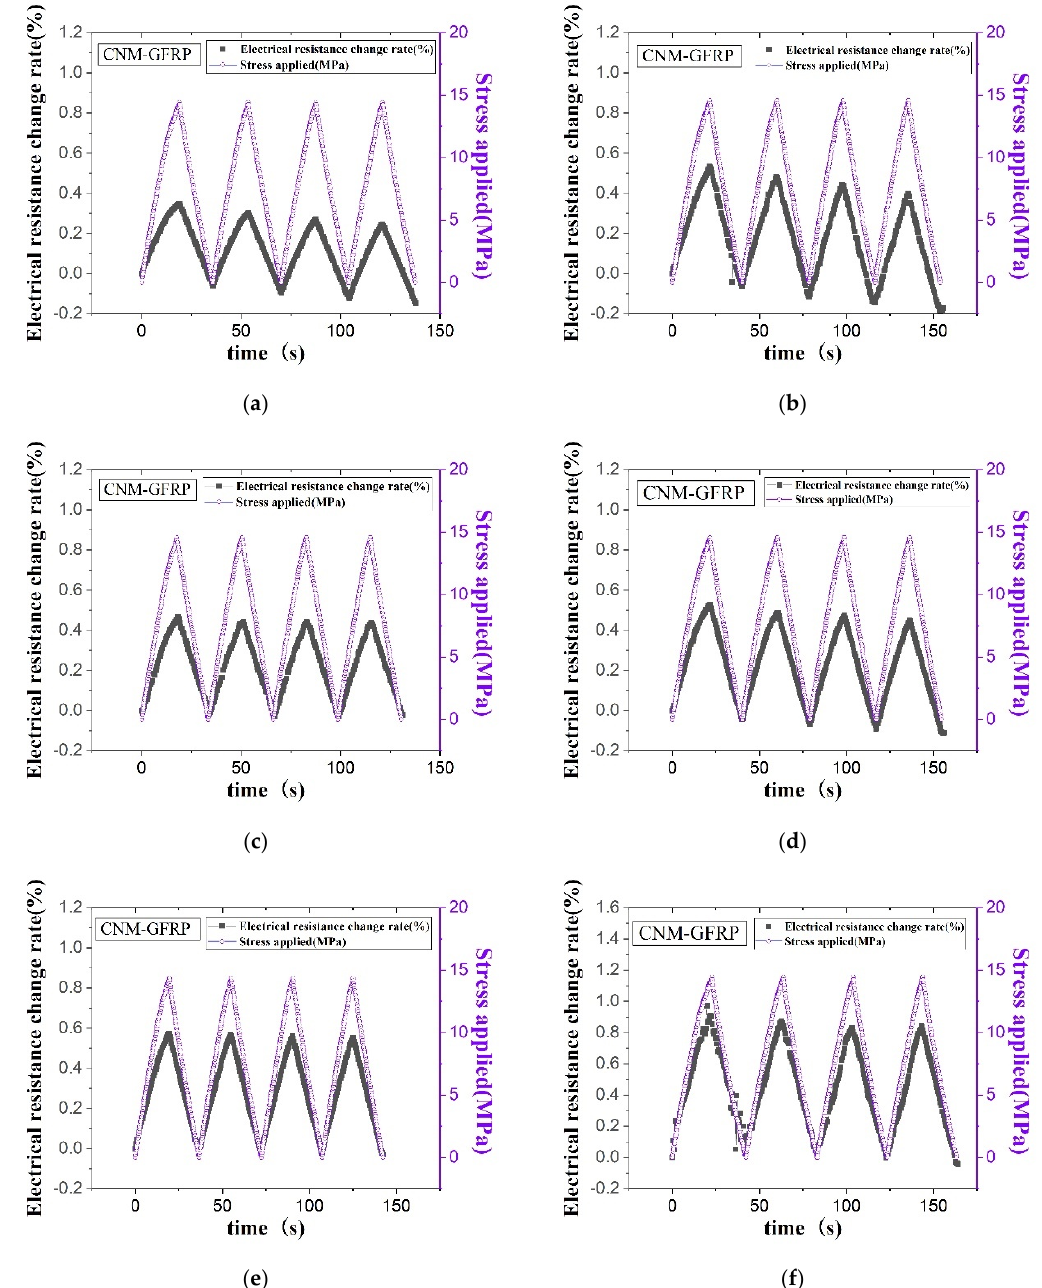
Figure 7. The electrical resistance change rate and applied stress of the ( a ) CNT-only GFRP 1.5% -2, ( b ) CNT-only GFRP 3% -1, ( c ) CNT–graphene GFRP 1.5% -3, ( d ) CNT–graphene GFRP 3% -1, ( e ) CNT–CNF GFRP 1.5% -1, and ( f ) CNT–CNF GFRP 3% -1 composites obtained through cyclic tensile loading tests.